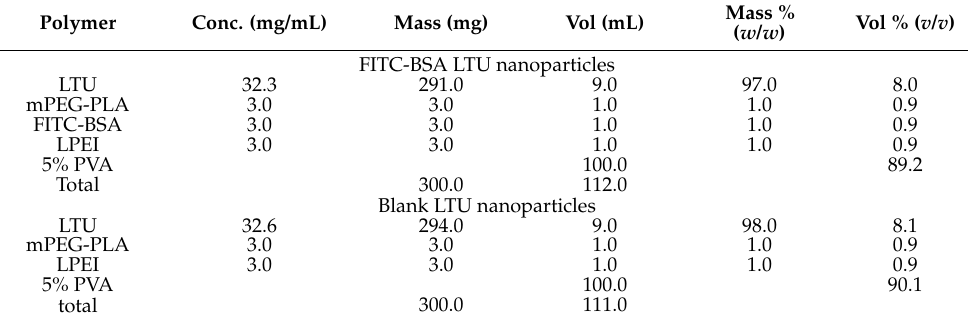
Table 1. Detailed compositions of LTU nanoparticle formulations (Blank and FITC-BSA LTU nanopar- ticles) produced using the double emulsion method.